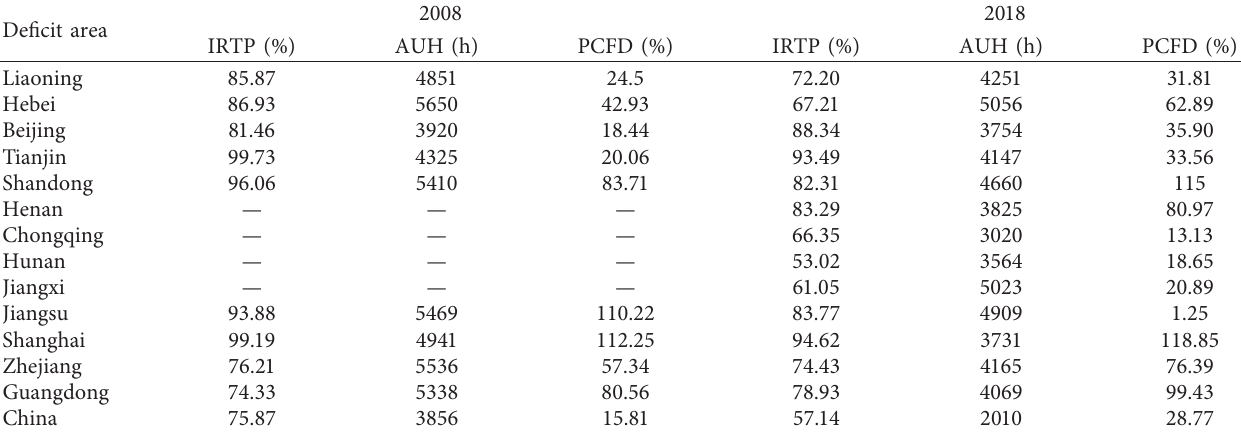
Table 2: TPIC and PCFD of China’s power deficit provinces in 2008 and 2018. Deficit